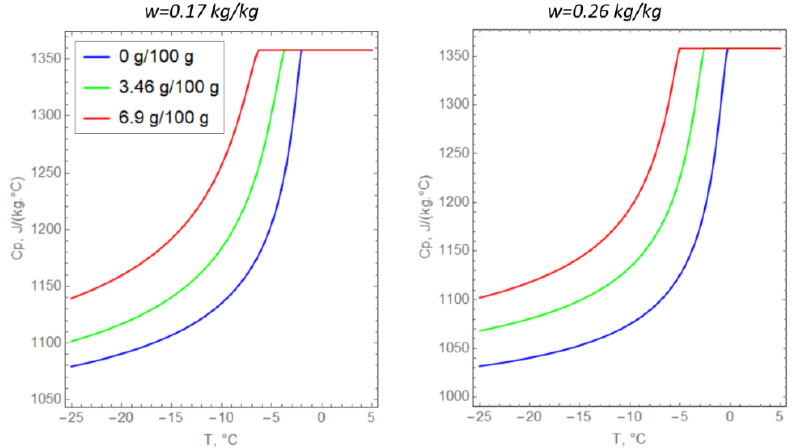
experimental data at nonzero pore water salinity was evaluated graphically (Figure 5).